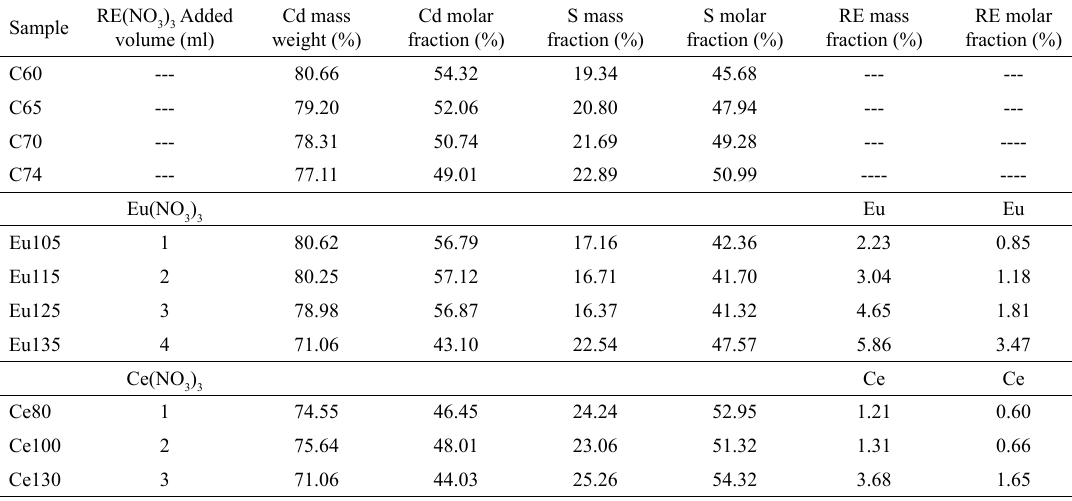
Table 1. It presents the CdS:RE 3+ films grown and the doping volume added to each one. The Cd, S and RE concentrations in the samples were estimated by EDS. The average errors with that were calculated percentage masses of different elements were for cadmium 1.25%, sulphur 0.35%, europium 0.25% and for cerium 0.30%. For a stoichiometric compound (CdS), the percentage atomic masses are cadmium 77.81% and 22.19% sulphur. The number that accompanies the sample name corresponds to the synthesis time.